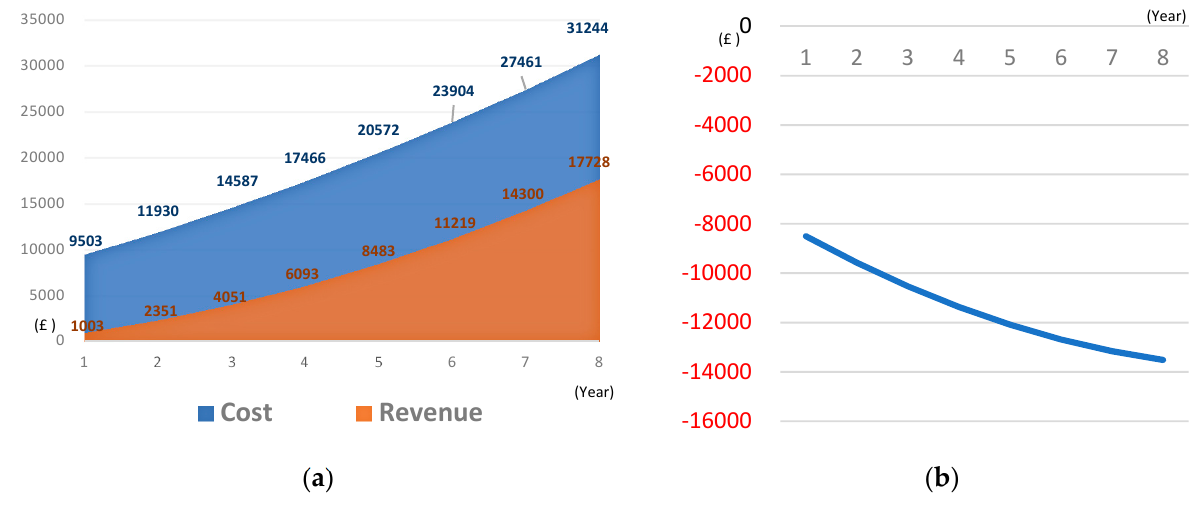
Figure 11. ( a , b ) Revenue analysis.